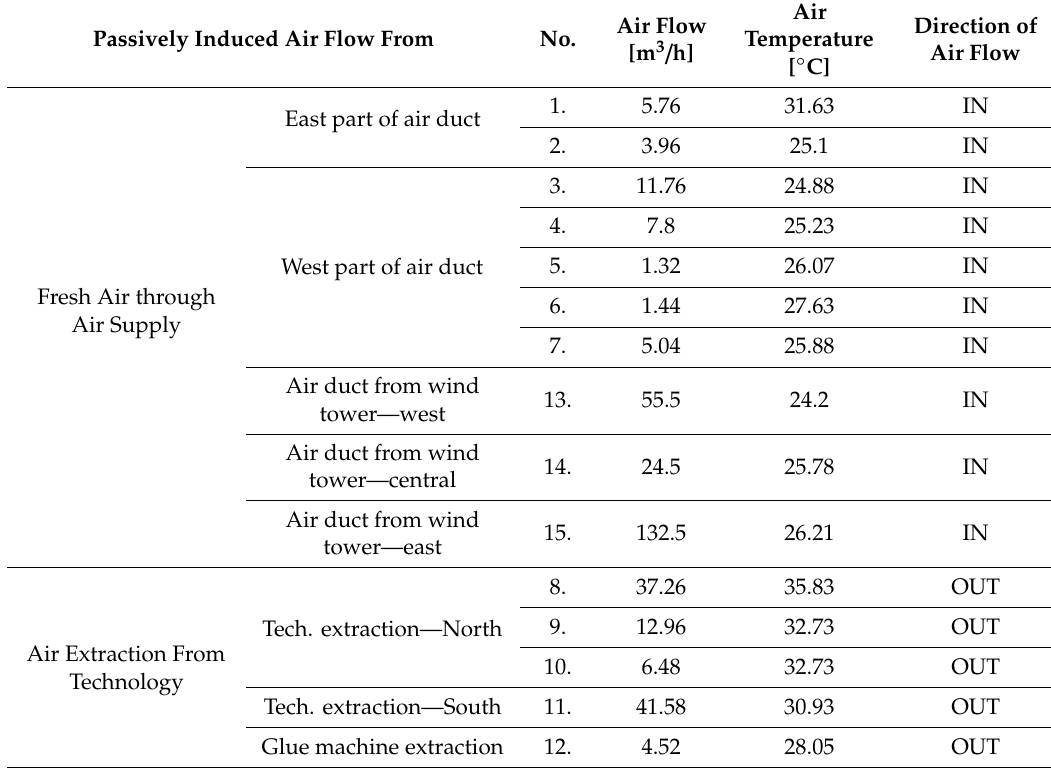
Figure 6. Location of measurements of infiltration volume flows and temperatures through the envelope openings and perimeter in the production hall. Table 2. Measured air flow rates and temperatures trough air duct inlets.